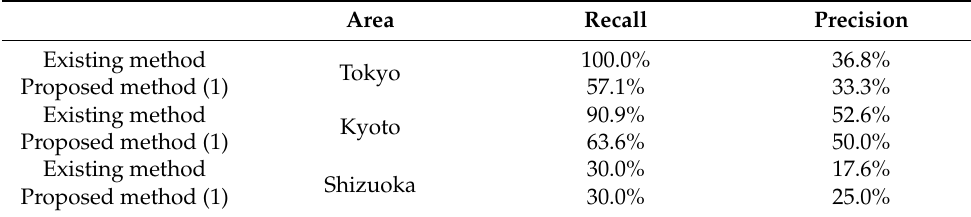
Table 2. Recall rate and precision rate between existing method and proposed method (1).